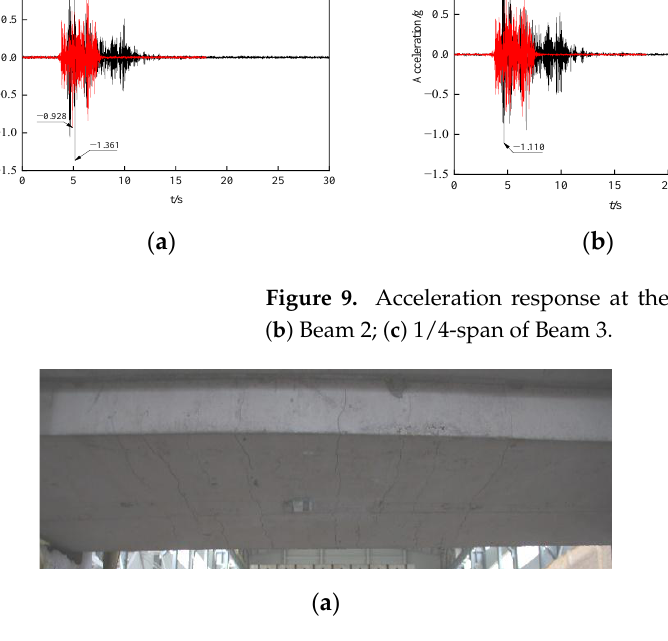
earlier and in more abundance in the test process, than for the curved beam 3, as shown